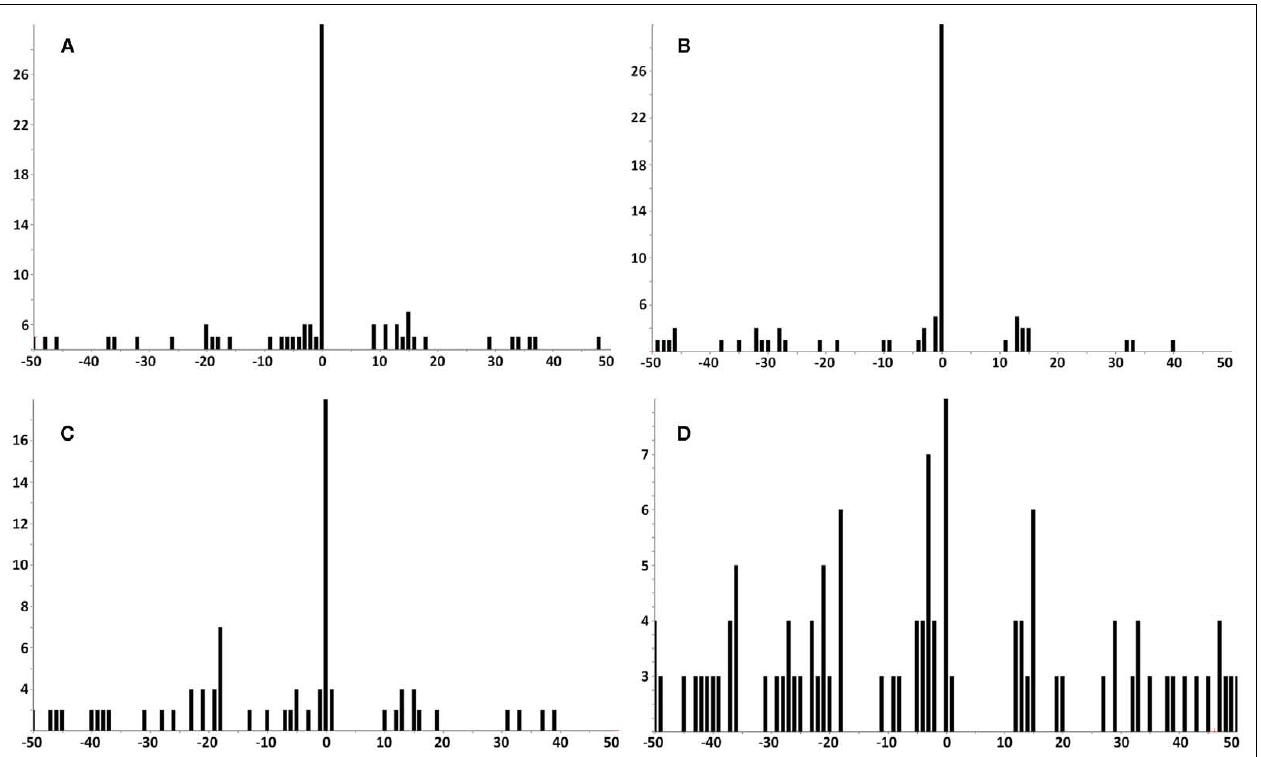
FIGUREA4 | Lower sensitivity MS 3 555.3/990.5 Poisson plots for detectingYMLDLQPET in HLA-A2 bound peptides from tumor samples. (A) Tumor sample #1; (B) sample #2; (C) sample #4; (D) sample #7.YMLDLQPET detection in samples 1, 2, and 4 are confirmed, but the detection significance in sample 7 is below threshold.